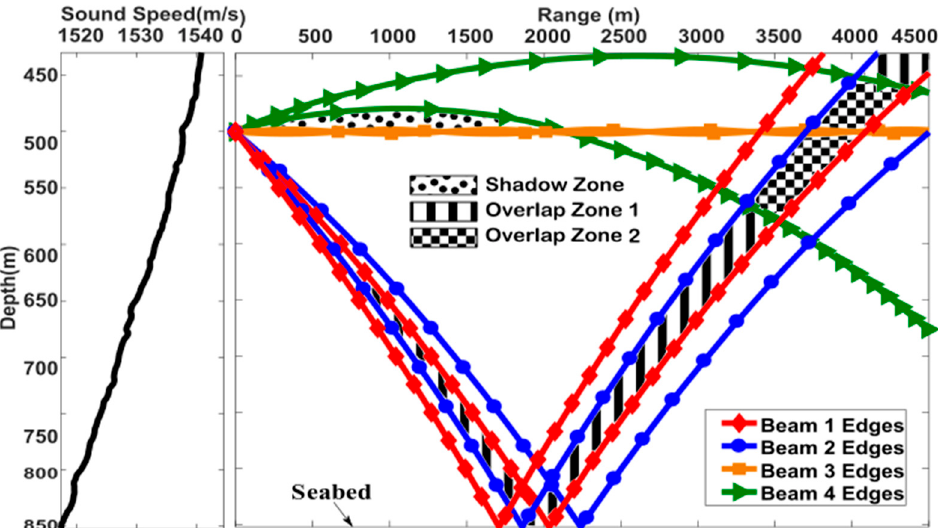
Figure 2. Illustration of shadow and overlapping regions where a transmitter is placed at depth of 500 m while the seabed is at 850 m. The left figure shows the sound speed profile while the right one shows the ray propagation path where the inhomogeneity of the medium complicates the spreading pattern of waves. Nodes laying in the shadow zones will not detect the transmitted waves while node in the overlapping regions receive multiple transmissions.